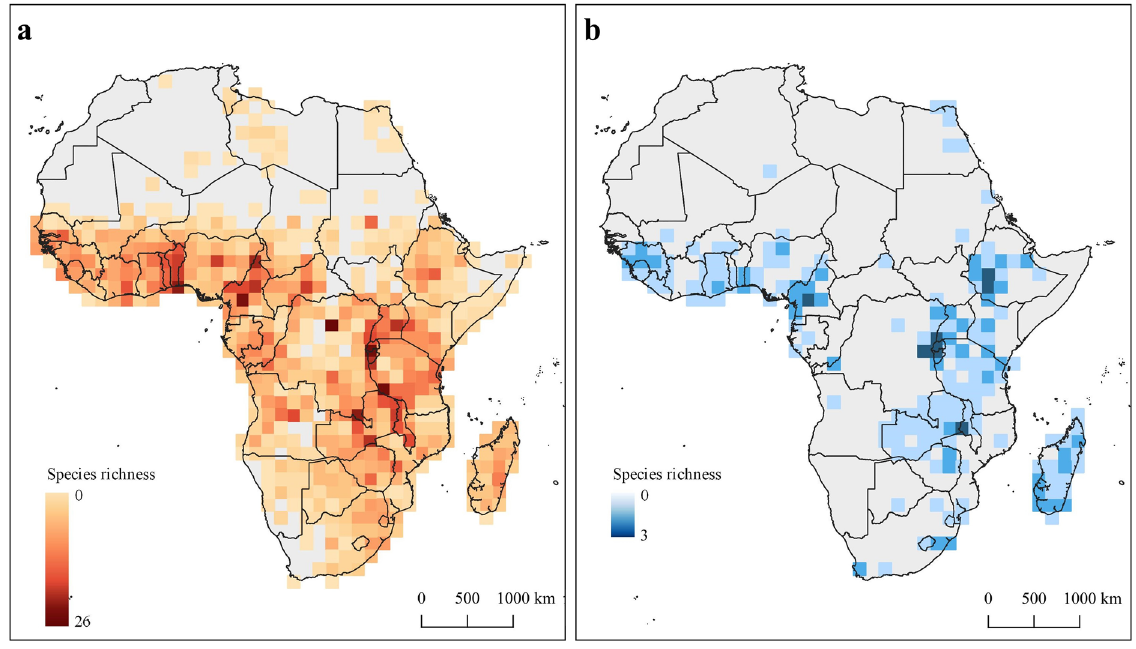
Figure 2. Species richness by cell of 200 × 200 km including native and introduced species of ( a ) Vigna and ( b ) Phaseolus . This figure was produced with the free available on-line software QGIS v.3.4.4 (http:// qgis. osgeo. org).